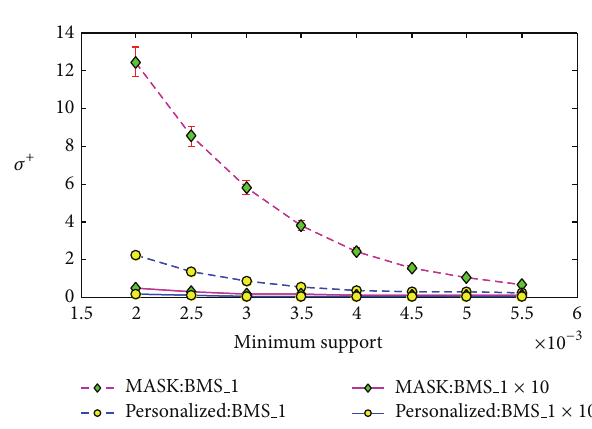
Figure 11: Frequent itemset added ration 𝜎 + versus minimum support on different size of datasets.